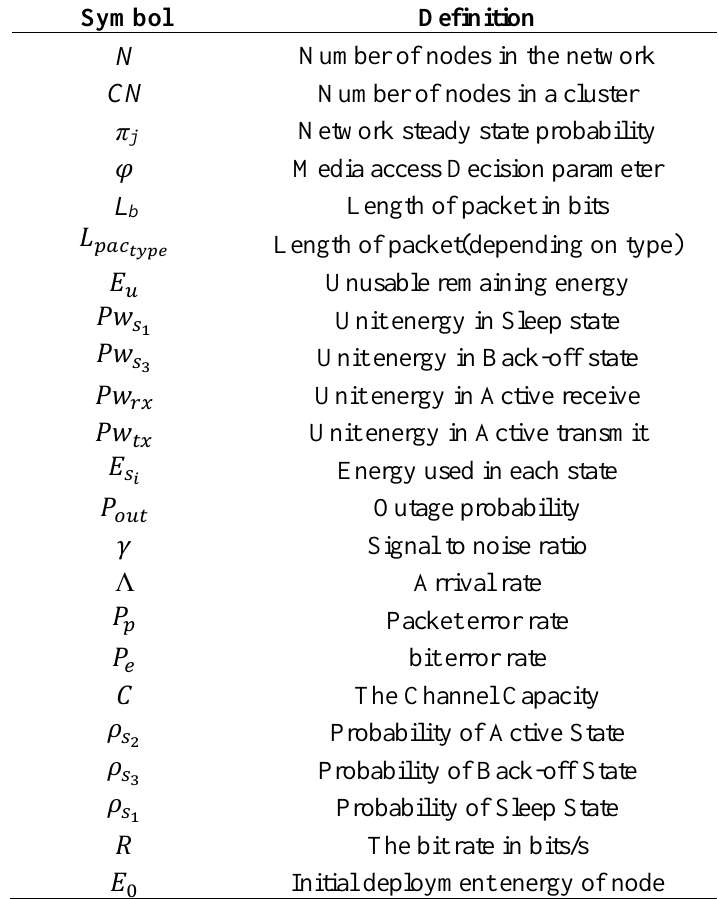
Table 1. Analysis Symbols